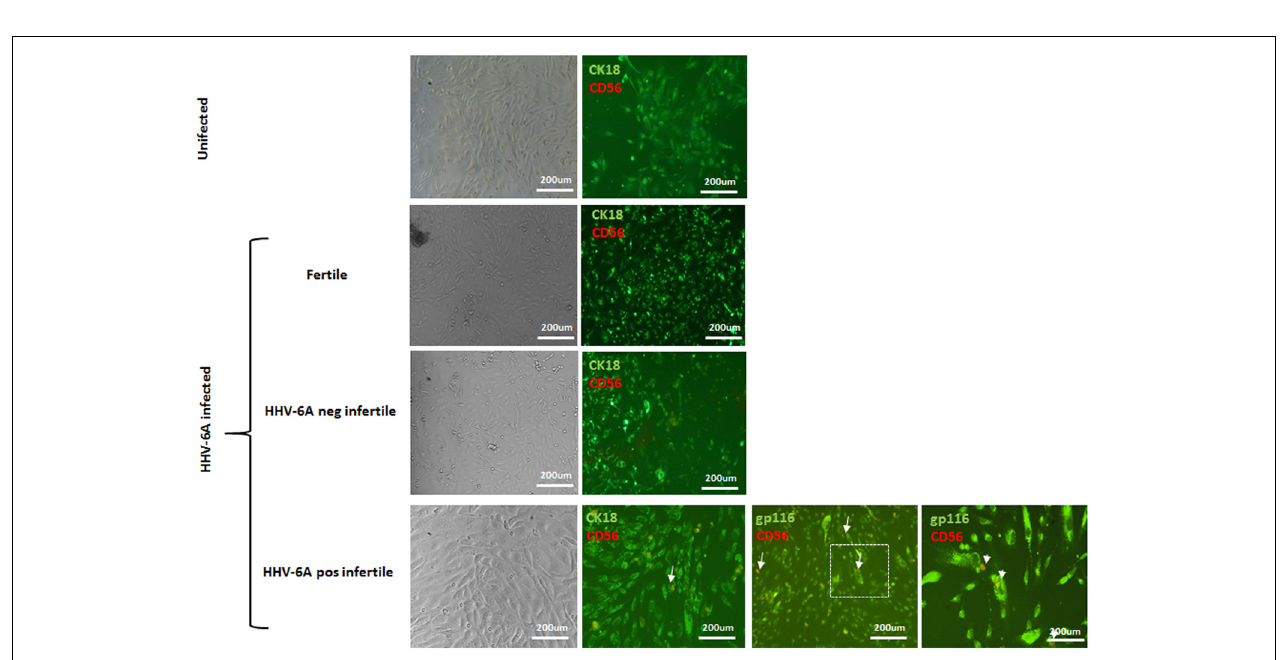
FIGURE 8 | Endometrial epithelial cells were infected for 72 h with HHV-6A. eNK cell were co-cultured for 4 h at a E/T ratio of 10. Endometrial epithelial cells were stained with CK18 (green), eNK cells with CD56 (red) and HHV-6A with gp116 (green). Images were taken in bright field left panels ) or fluorescence ( right panels ) (Nikon Eclipse TE2000S) equipped with a digital camera. Original magnification 20 × and 100 × .